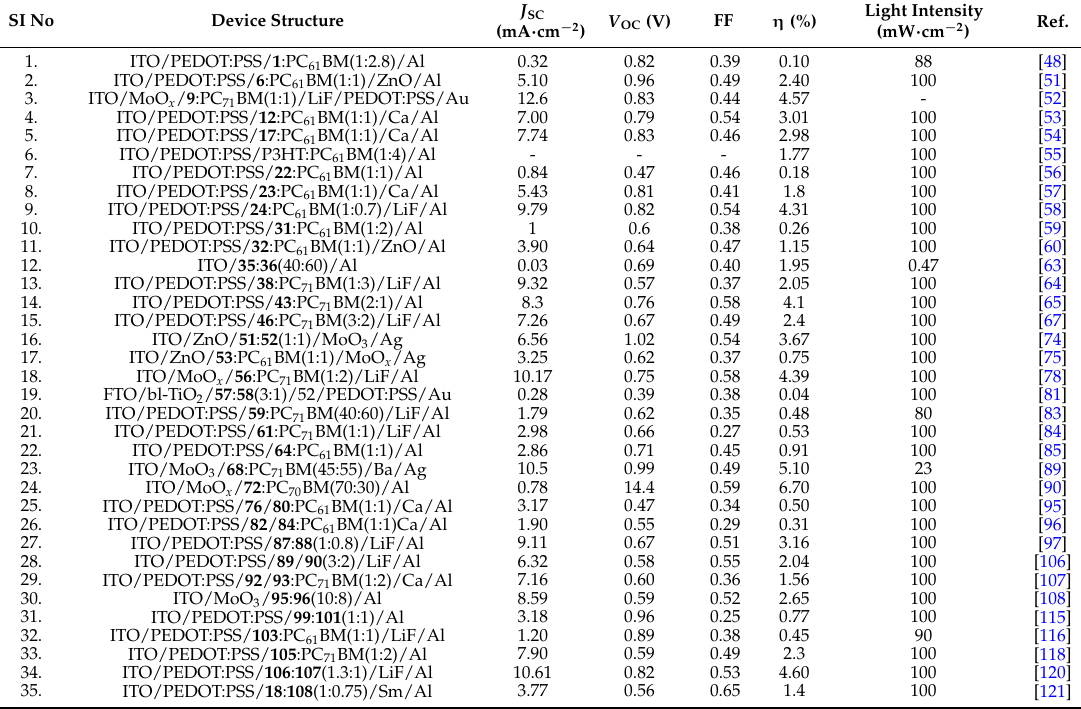
Table 1. Photovoltaic parameters of the BHJ solar cells discussed in this review. SI No Device